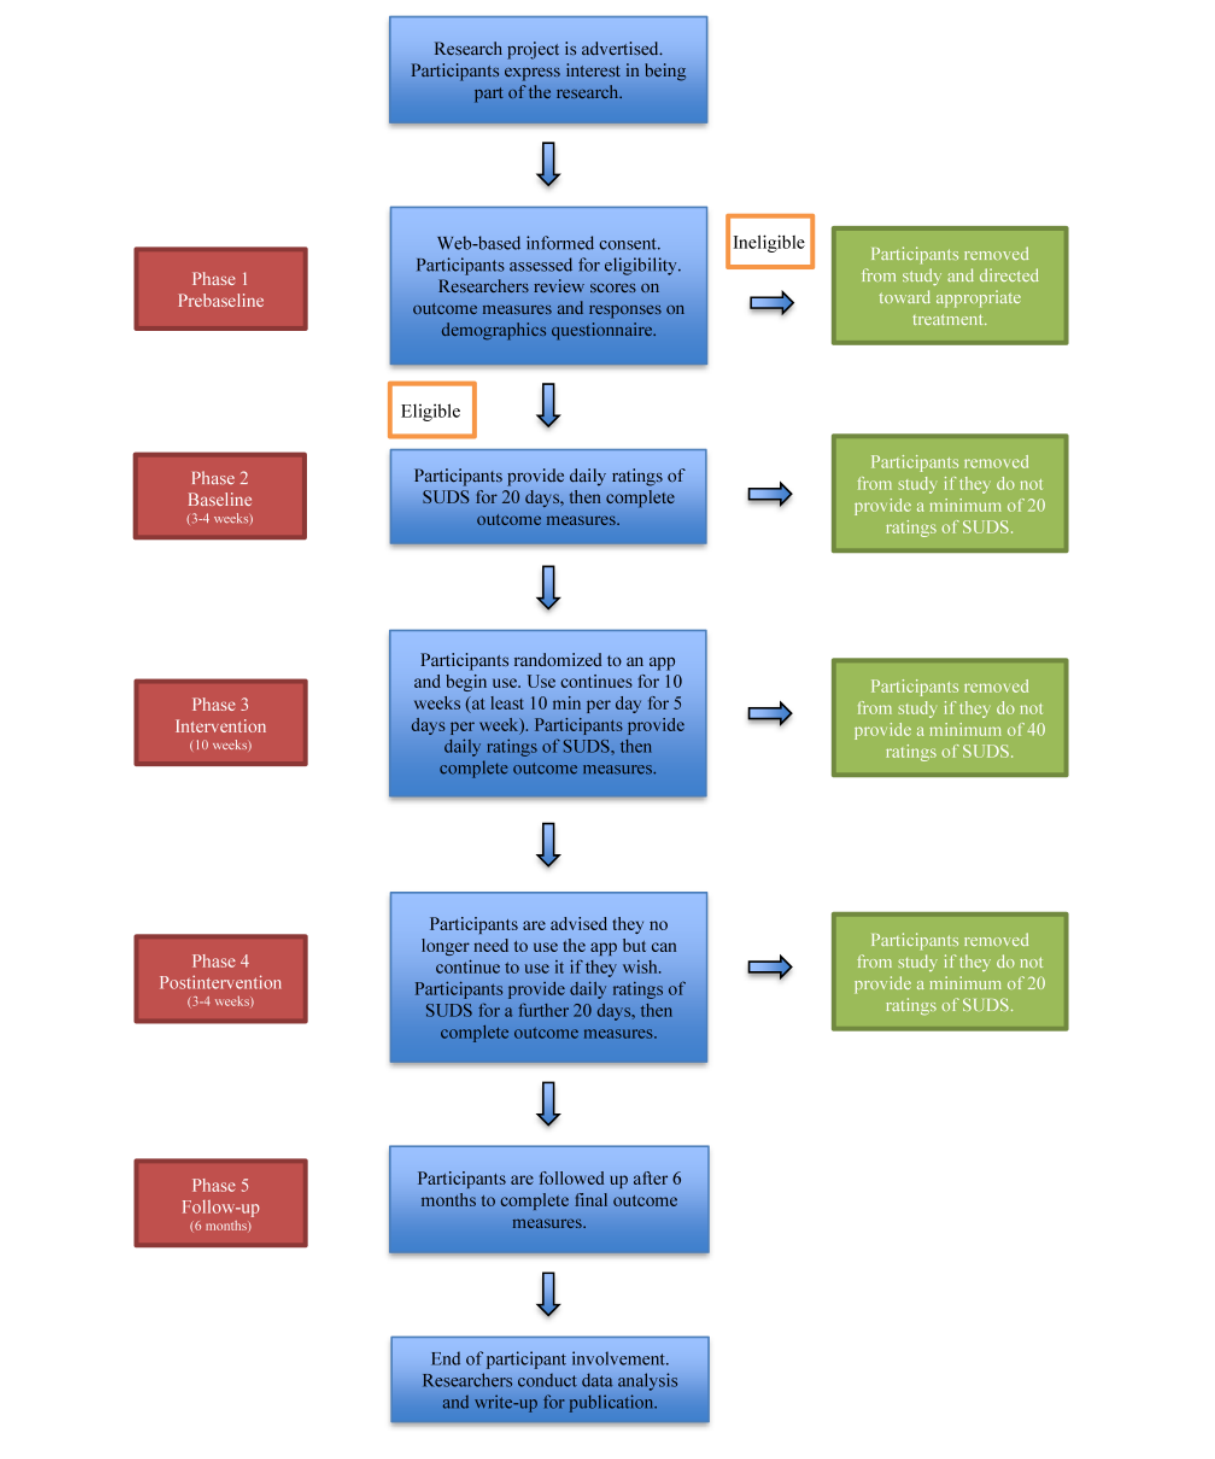
Figure 2. Flowchart of study and participant